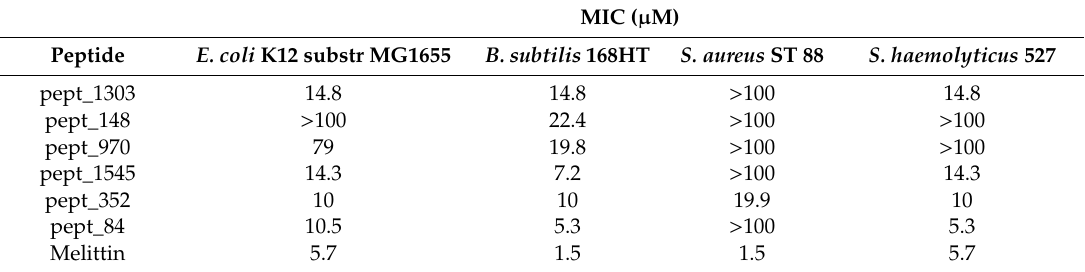
Table 2. Antimicrobial properties of AMPs.